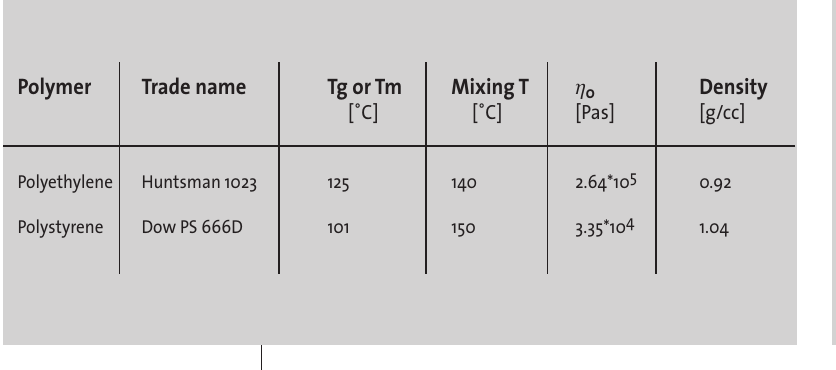
Table 1: Polymers used in the hybrids. Fig. 1: Frequency dependen- cies of the complex modulus for the Pglass at the temper- atures